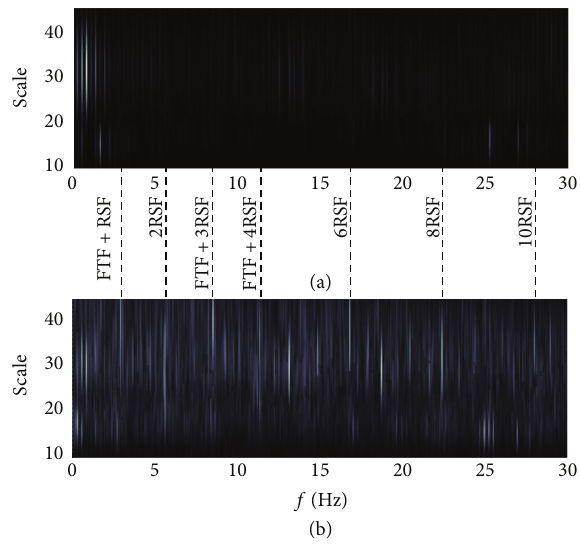
Figure 12: Multiscale enveloping spectrogram in chn08 and chf08. (a) Normal and (b) fault.